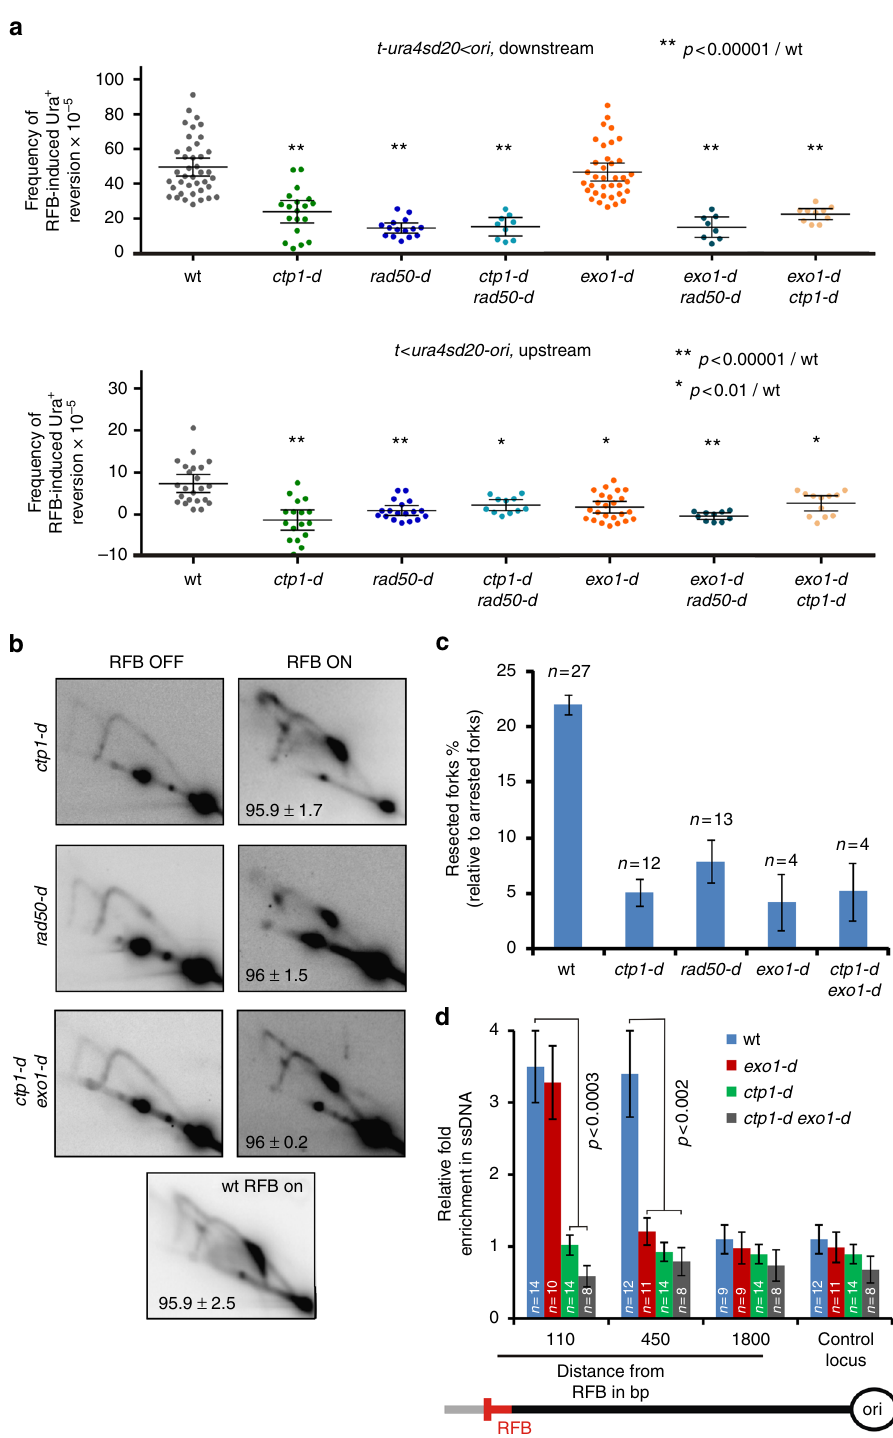
Fig. 2 MRN-Ctp1-mediated initial fork-resection primes long-range resection by Exo1. a Frequency of downstream RFB-induced Ura + reversion (top panel, t-ura4sd20 < ori ) and upstream RFB-induced Ura + reversion (bottom panel, t < ura4sd20-ori ) as described on Fig. 1c. b Representative RI analysis by 2DGE in indicated strains upon activation (RFB ON) or not (RFB OFF) of the RTS1 -RFB, as described on Fig. 1e. c Quanti fi cation of forks undergoing resection ( “ tail signal ” ), relative to the intensity of terminally arrested forks, as described on Fig. 1f. Values are means of n samples from independent biological replicates ± 95% CI. d Relative enrichment of ssDNA formed upstream from the RTS1 -RFB, as described on Fig. 1g. Values are means of n samples from independent biological replicates ± SEM. Statistics were calculated using the non-parametric Mann-Whitney U test. See Supplementary Fig. 2 for the analysis of the mre11 nuclease dead